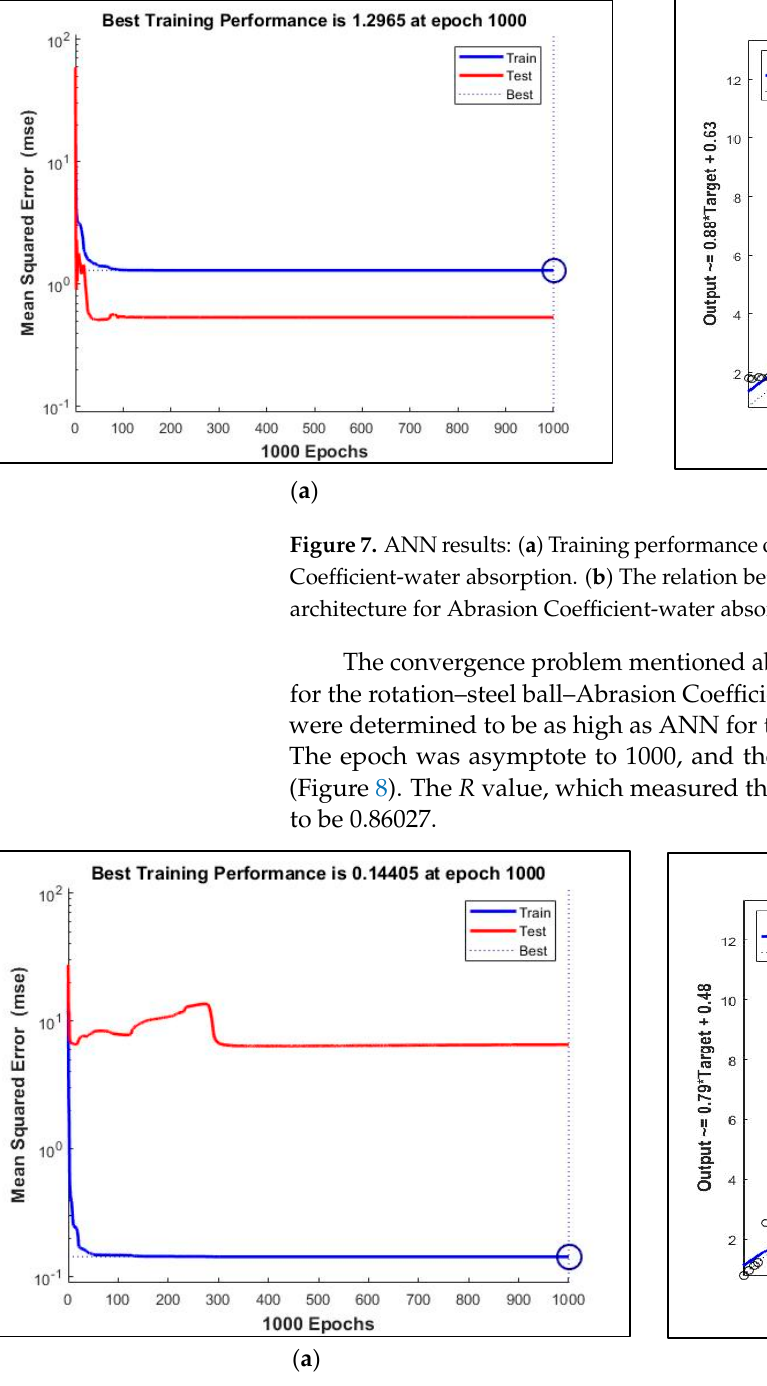
Figure 8. ANN results: ( a ) Training performance of artificial neuron network architecture for rotation- steel ball-Abrasion Coefficient-water absorption. ( b ) The relation between predicted values of artificial neuron network architecture for rotation-steel ball-Abrasion Coefficient-water absorption ( y -axis) and experimental values ( x